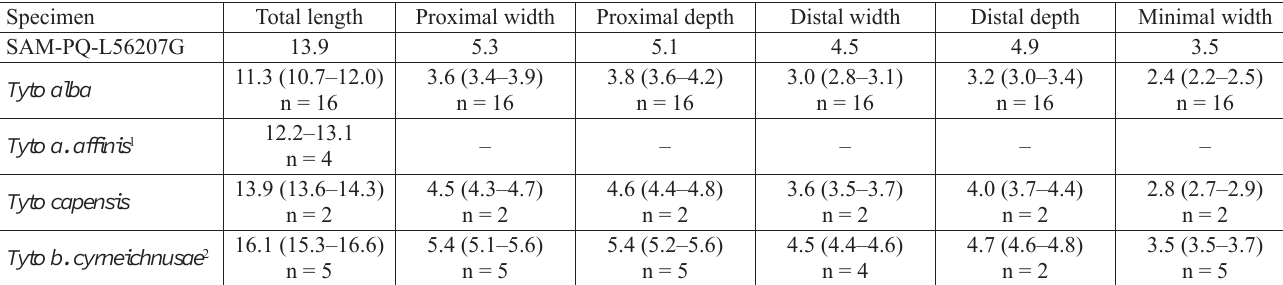
Table 3. Measurements (in mm) of pedal phalanx III/2 SAM-PQ-L56207G of Tyto richae sp. nov. from Langebaanweg in comparison to corre- sponding measurements of extant T. alba , T. capensis , and fossil T. b. cyrneichnusae . 1 measurements after Brodkorb and Mourer-Chauviré (1984); 2 measurements after Louchart (2002); n, sample